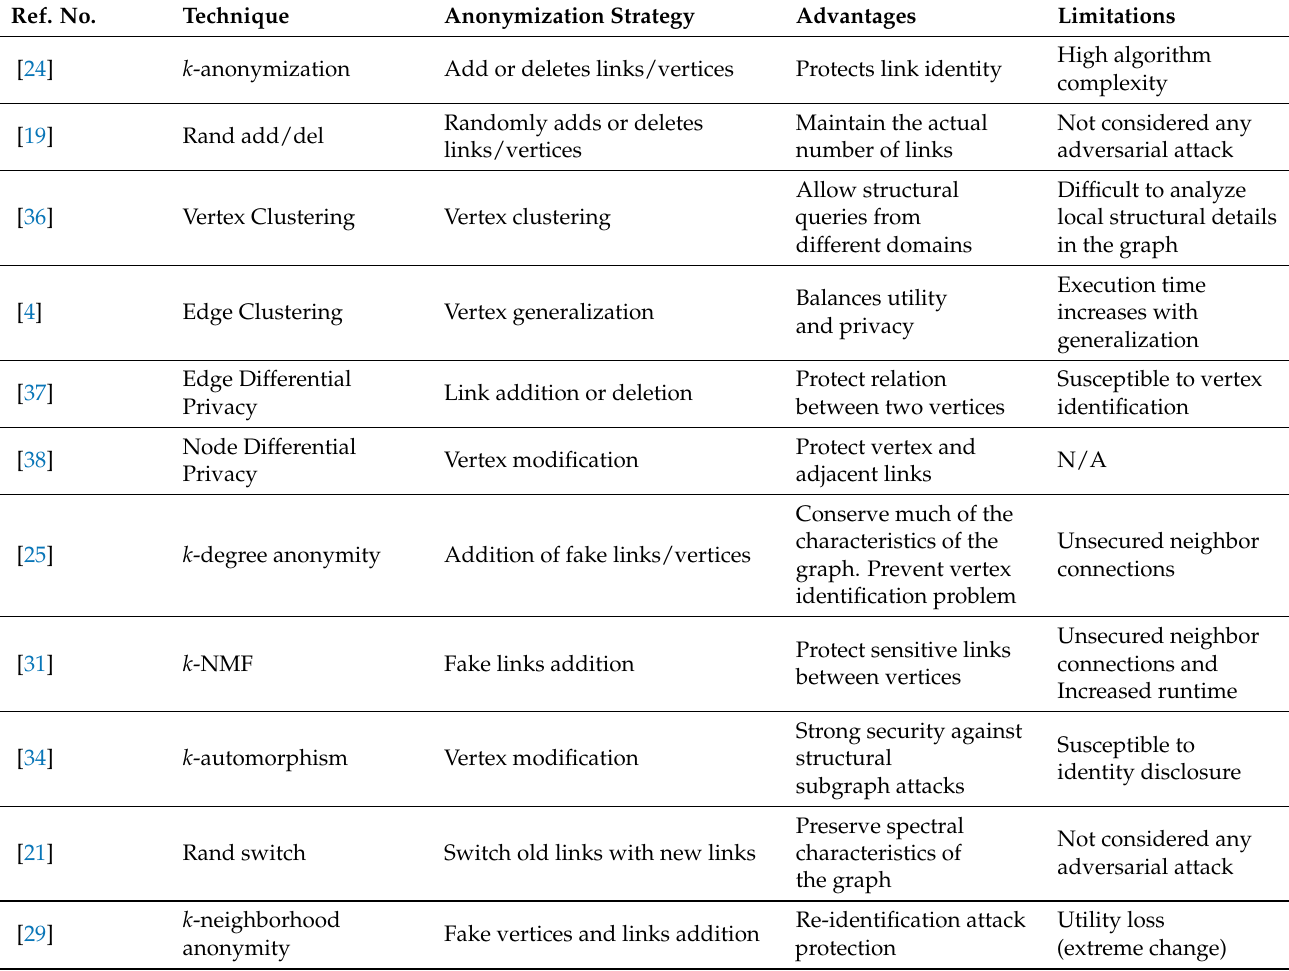
Table 1. Graph anonymization